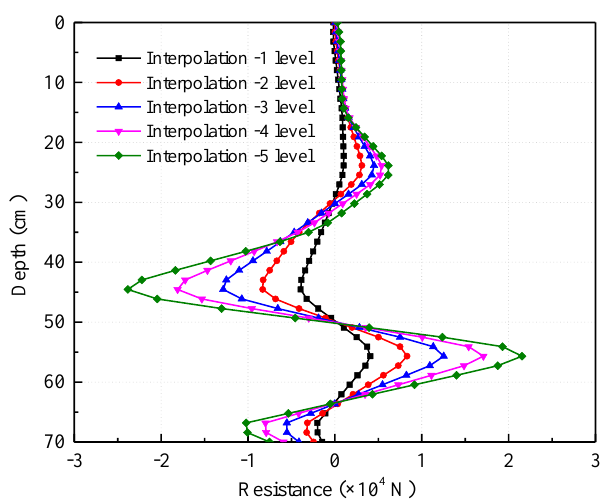
Figure 12. Soil resistance distribution along the length of the pile.